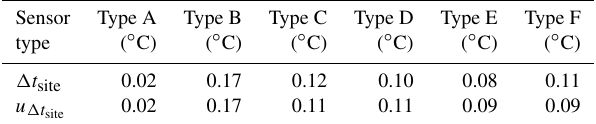
Table 4. Results of the evaluation of (cid:49)t site and the associated un- certainties u (cid:49)t for each instrument site